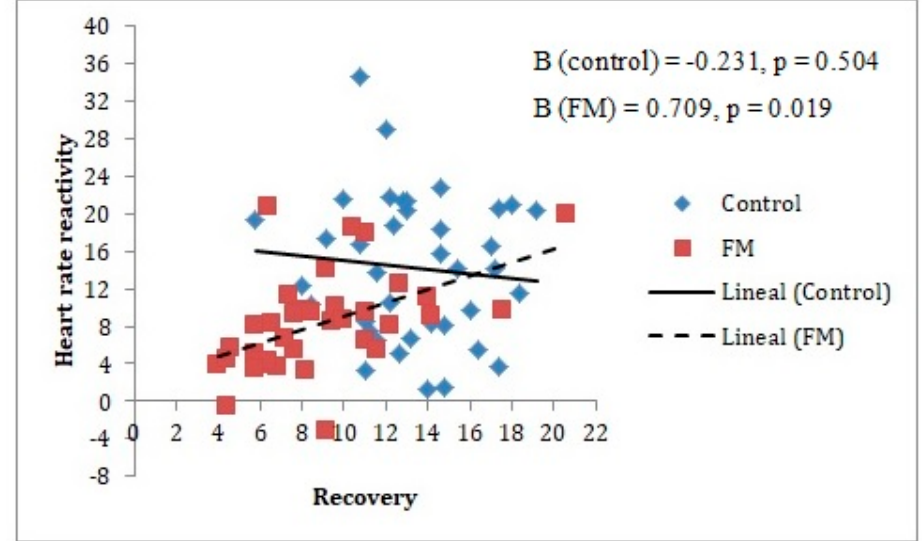
Figure 4. Group moderating role between heart rate reactivity measure and General recovery factor. The reactivity index is represented as the di ff erence between the baseline and the stress measurements (task minus baseline). In the figure, the lines represent raw scores. As can be observed, only in the FM group does heart rate reactivity increase significantly when General recovery factor levels increase. Note: FM = fibromyalgia; Heart rate reactivity is measured in bpm = beats per